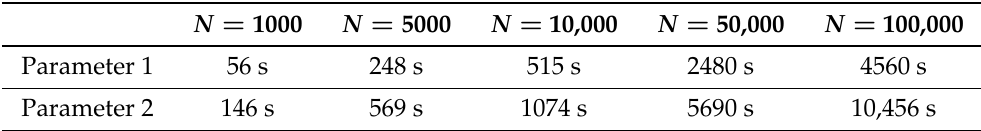
Table 3. The CPU time of the DNN method under different parameters and training times ( D E = 200, D I = 30). N = 1000 N = 5000 N = 10,000 N = 50,000 N = 100,000 Parameter 1